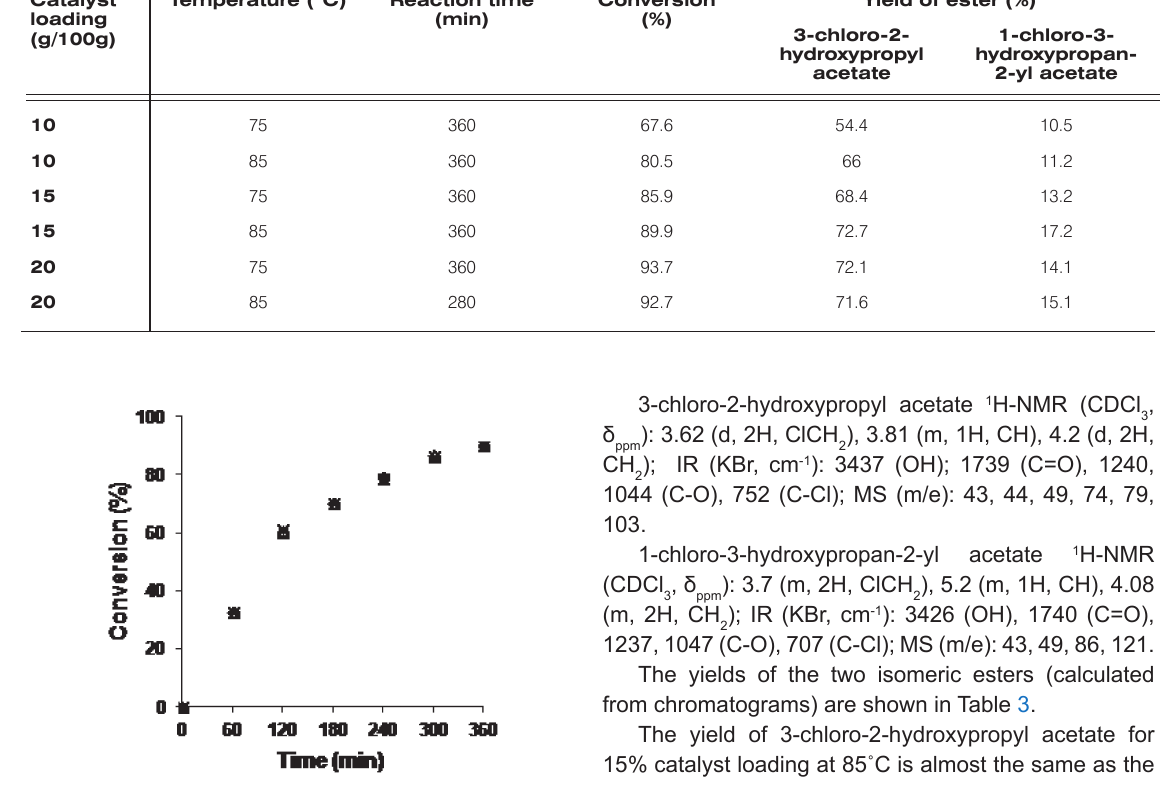
Table 3. The effect of temperature and catalyst loading on conversion and selectivity of reaction. Catalyst loading